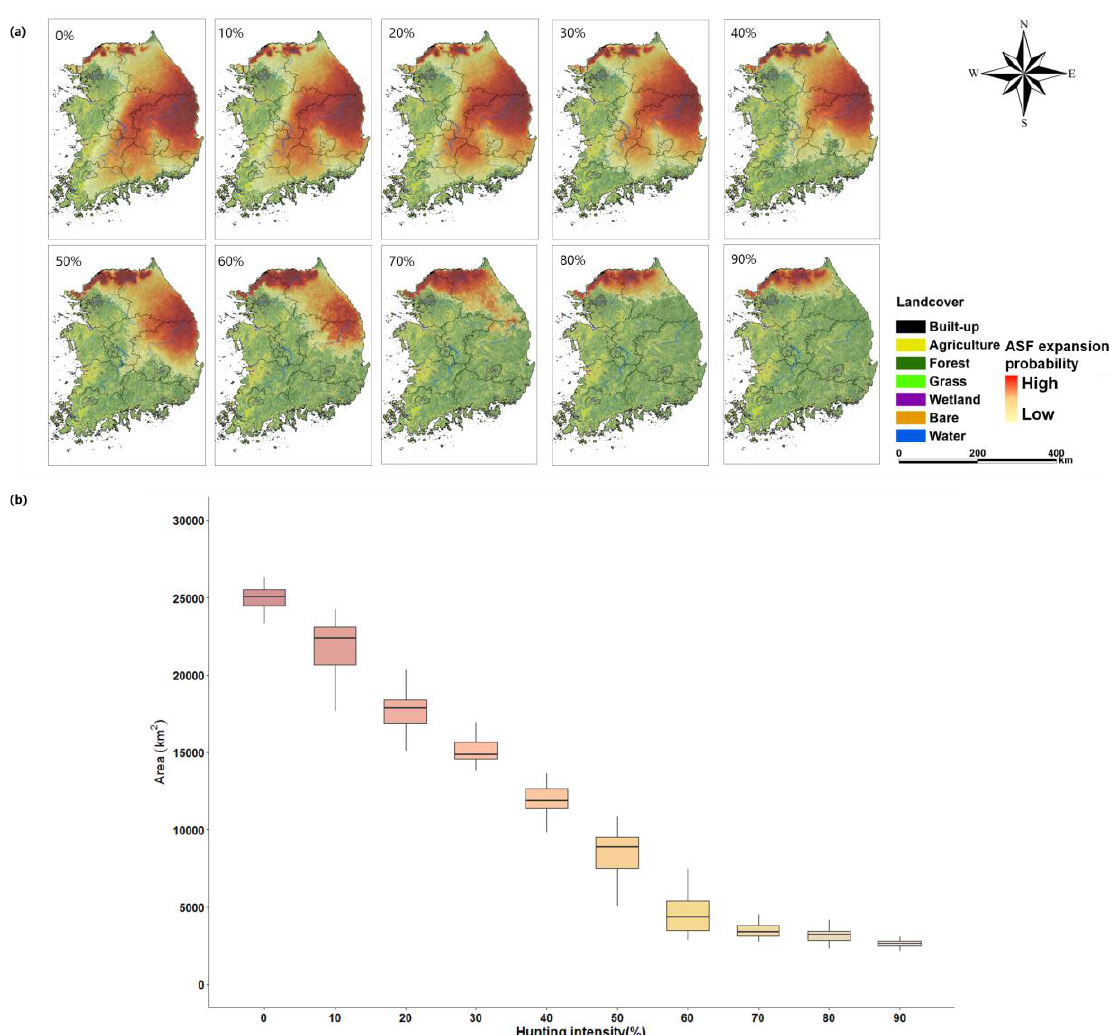
Figure 5. The ASF expansion area depends on the hunting rate. ( a ) Spatial distribution of the estimated ASF expansion area and ( b ) the average of ASF expansion area after a 3-year simulation.